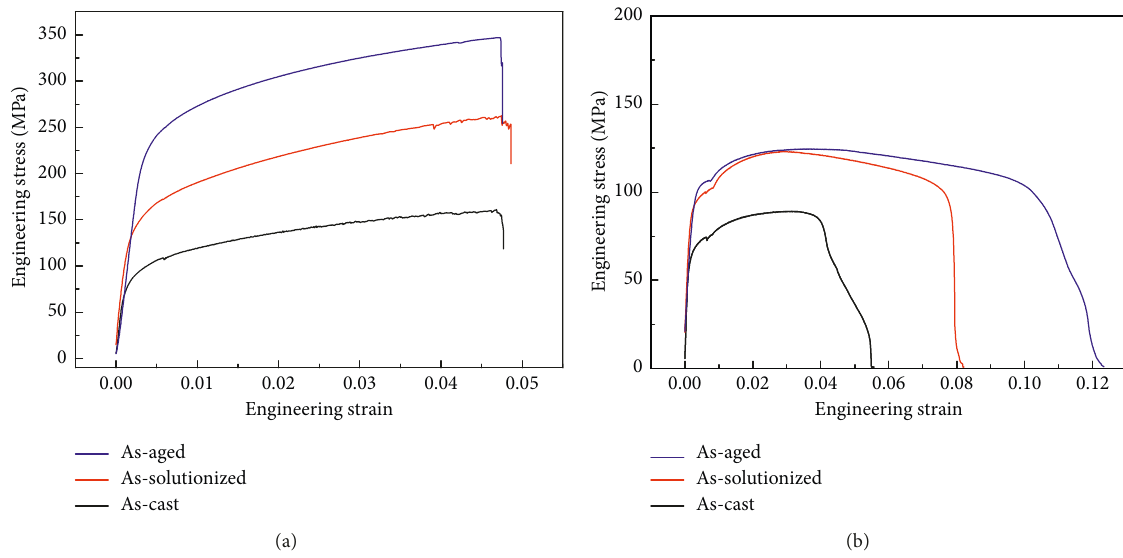
Figure 10: Typical engineering stress-strain curves of the A